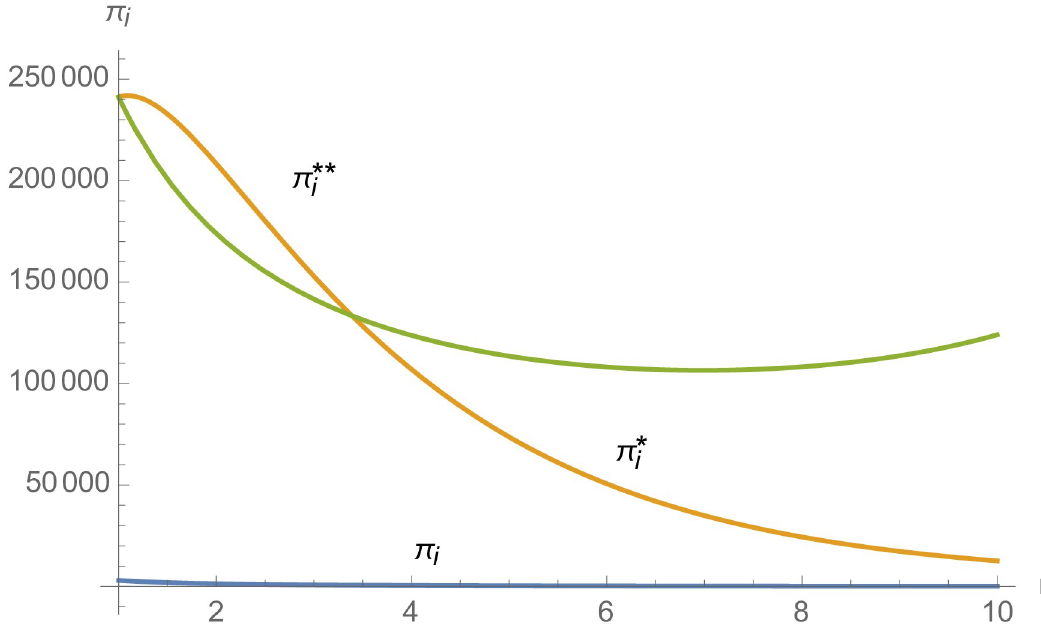
Fig 36. The impact of n on π